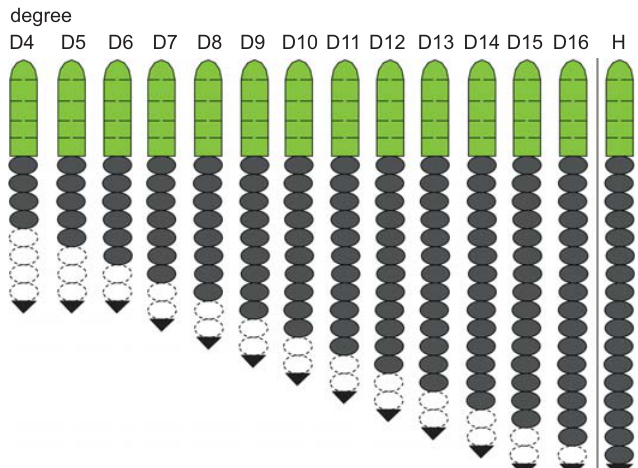
Fig. 8. Trunk development schedule of Changaspis elongata Lee in Chien, 1961. Green, dark grey, white, and black represent cephalon, thoracic seg- ments, pygidial segments, and terminal axial piece, respectively. Dotted lines represent estimated, because of axial ring of pygidium faint.